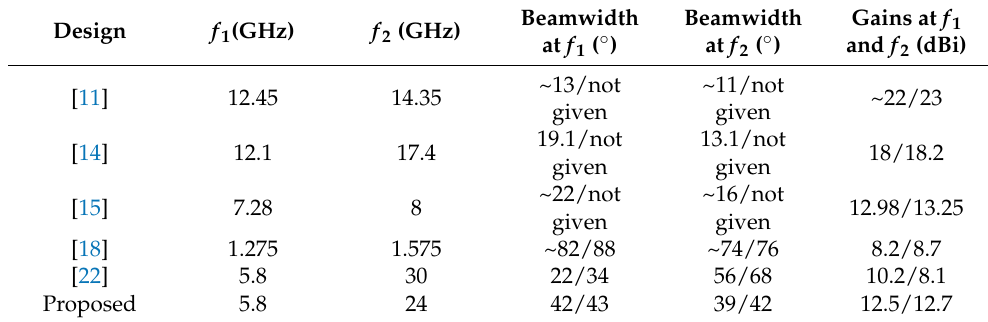
Table 2. Comparisons of the proposed antenna with other dual-band antenna.